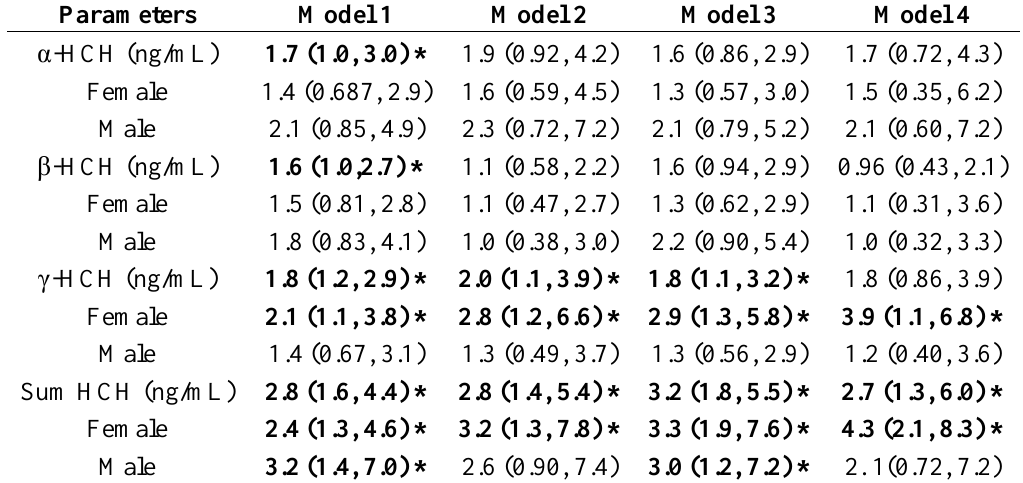
Table 3. Multiple logistic regression models for POP concentrations and